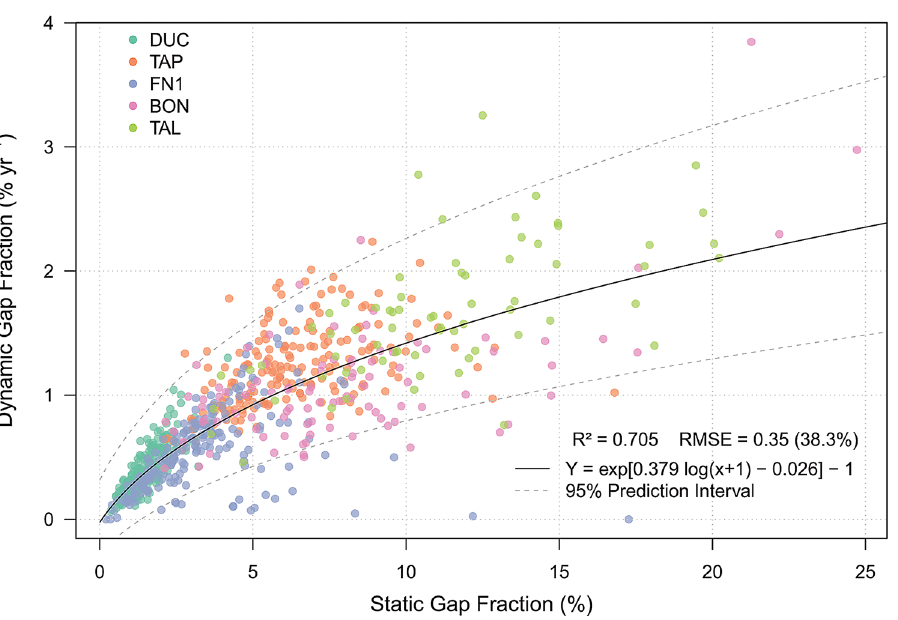
Figure 2. Relationship between static gap fraction (%) and annualized dynamic gap fraction (% year −1 ) for 5-ha plot areas ( n = 780) over the five studied sites (DUC, TAP, FN1, BON, and